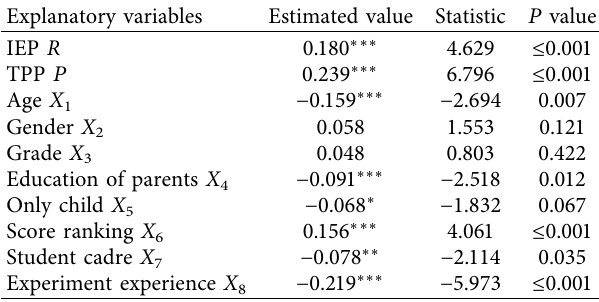
Table 3: Estimated values of parameters in the regression model. Explanatory